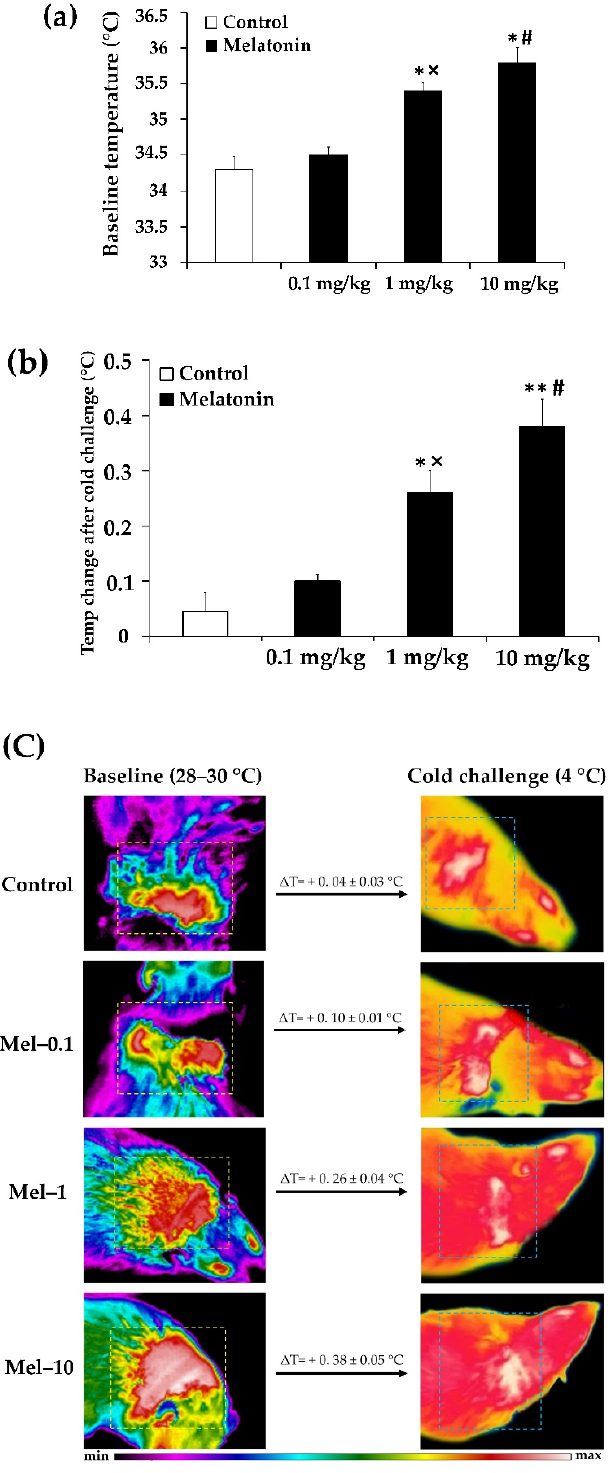
Figure 1. Dose-dependent effects of melatonin on iBAT thermogenesis in Zücker diabetic fatty rats as measured by infrared thermography. ( a , b ) Quantification of the interscapular skin temperature at baseline ( a ) and after acute cold challenge ( b ). ( c ) Representative infrared thermal images of the interscapular skin temperature at baseline and after acute cold challenge. Mel-0.1, Mel-1, and Mel-10: melatonin at a dose of 0.1, 1, and 10 mg/kg b.w, respectively. Values are means ± S.D ( n = 4). * p < 0.05, ** p < 0.01 Mel-1 and Mel-10 vs. Control; # p < 0.05 Mel-10 vs. Mel-0.1; × p < 0.05 Mel-1 vs. Mel-0.1 (One-way ANOVA with Tukey post hoc